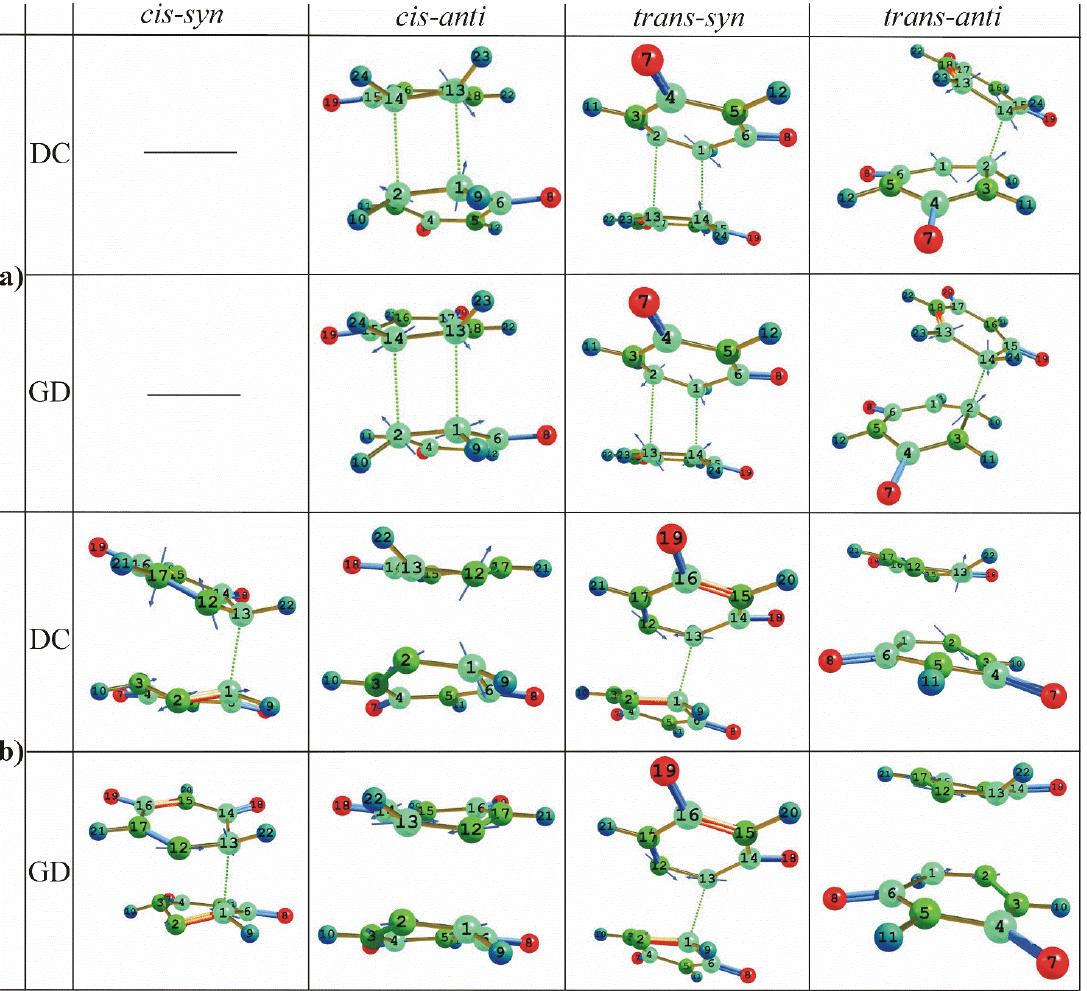
Fig. S2. Branching space vectors (Gradient Difference and Derivative Coupling) of the conical intersections S /S of a) Uracil and b) 0 1